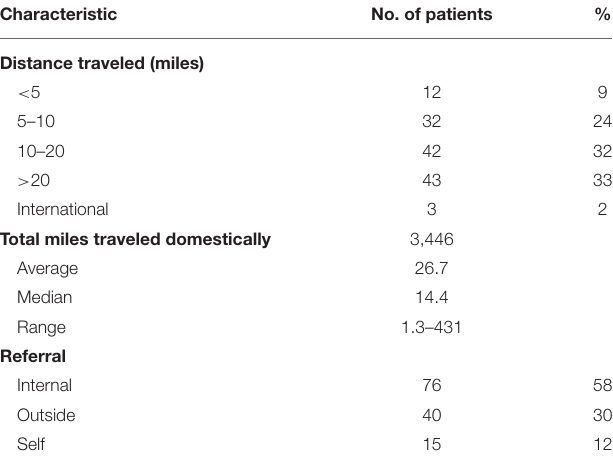
TABLE 4 | Plan and insurance